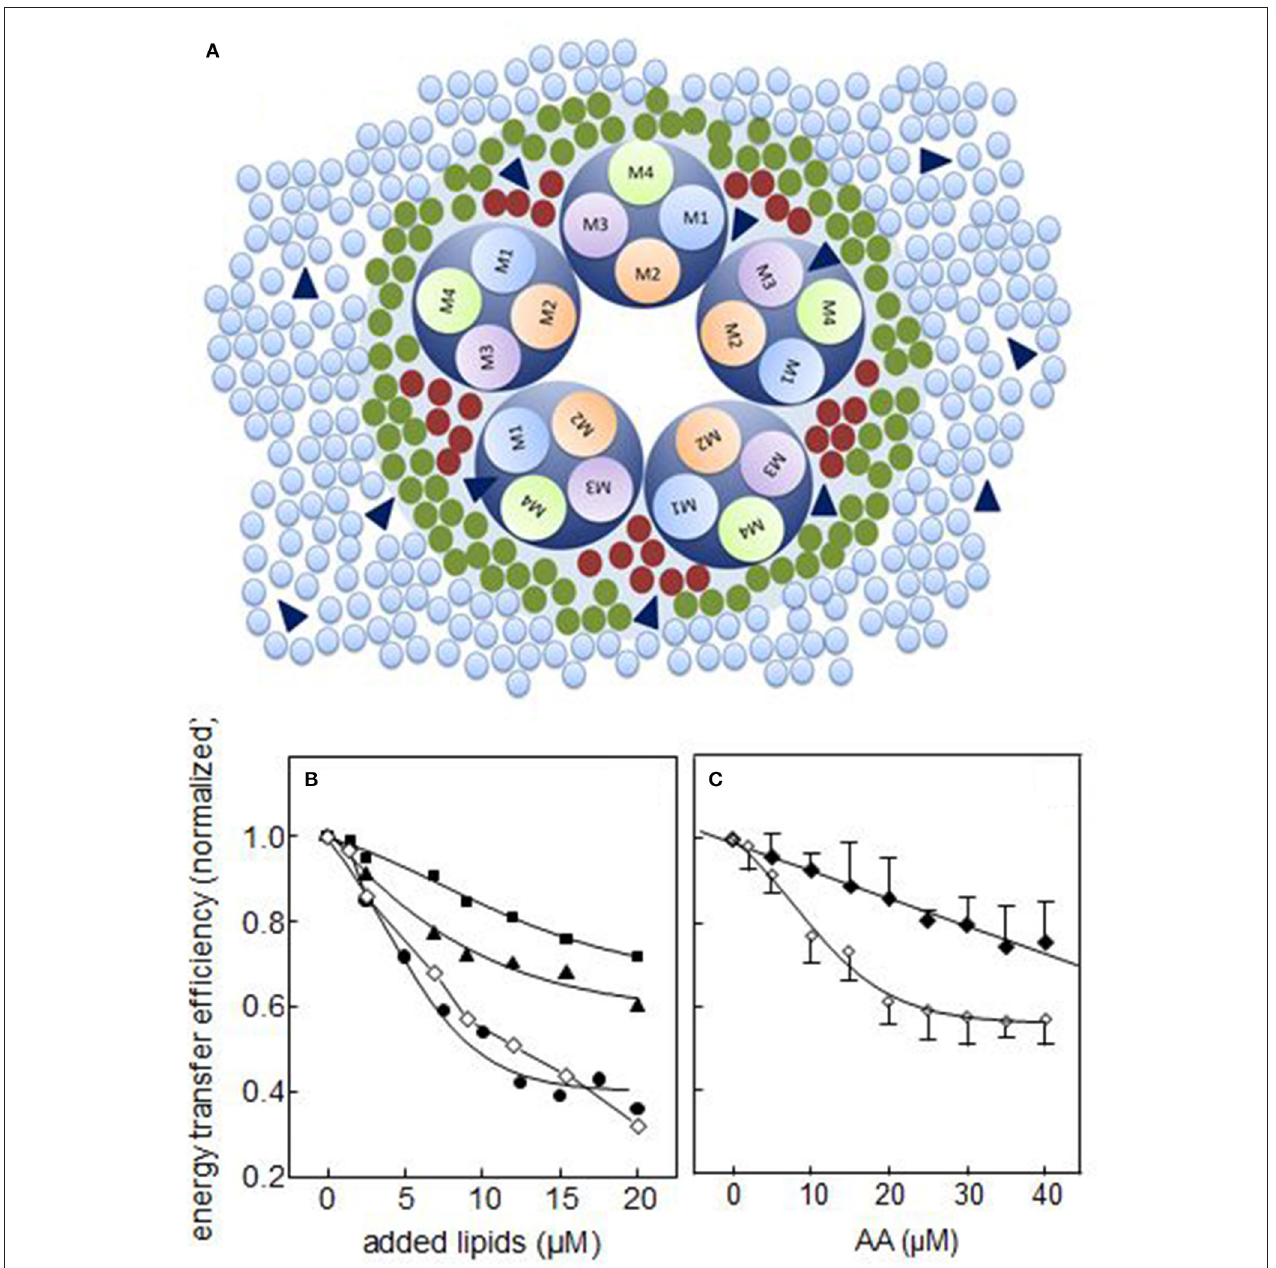
FIGURE 1 | (A) Schematic diagram of a direct mechanism of action of FFA on nAChR function. The scheme illustrates the nAChR-lipid relationship in a receptor-rich membrane, outlining the spatial distribution of the transmembrane segments (TM1, TM2, TM3, and TM4) and the surrounding lipid shell. Three lipid topologies are indicated: non-annular lipids (bordeaux • ), annular lipids (green • ) and bulk lipids (light blue • ). FFA (blue N ) can be found in any of these three domains. (B,C) Experimental studies on annular and non-annular sites using the efficiency ( E ) of the Förster resonance energy transfer (FRET) process between the intrinsic fluorescence of T. californica nAChR membranes and the extrinsic fluorescent probe Laurdan; (B) in the presence of increasing concentrations of DOPC ( (cid:4) ), cholesterol hemisuccinate (CHS, N ), and oleic acid ( • ), where the symbol ( ♦ ) corresponds to the sum of E of DOPC and CHS (from Antollini and Barrantes, 1998) and (C) in the presence of increasing concentrations of arachidonic acid with the nAChR in the resting (“R”, ♦ ) or the desensitized (“D”, (cid:7) ) state. The latter was generated by incubation of the membrane with 1mM carbamoylcholine prior to the fluorescence measurements (From Fernández Nievas et al., 2007).